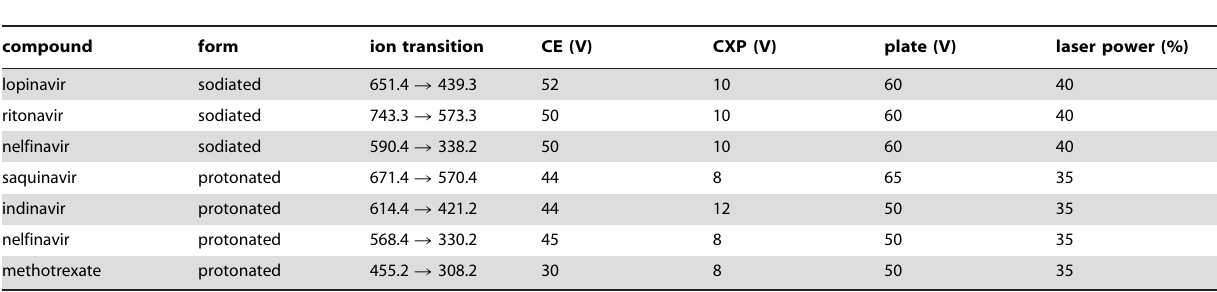
Table 1. Instrument settings for quantitative analysis of HIV protease inhibitors.